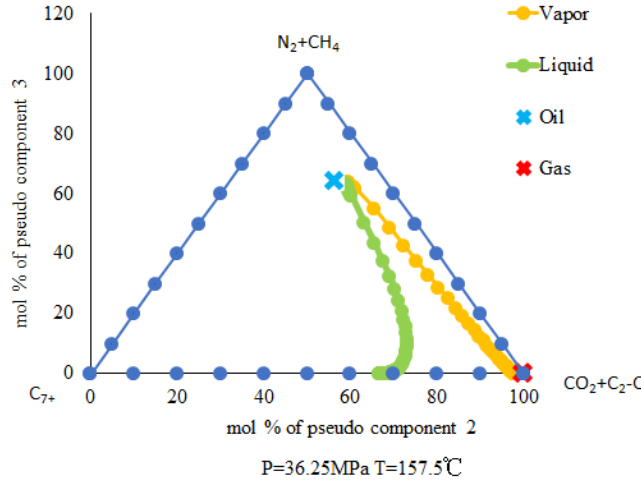
Figure 13. Pseudo-ternary phase diagram of the original formation fluid.